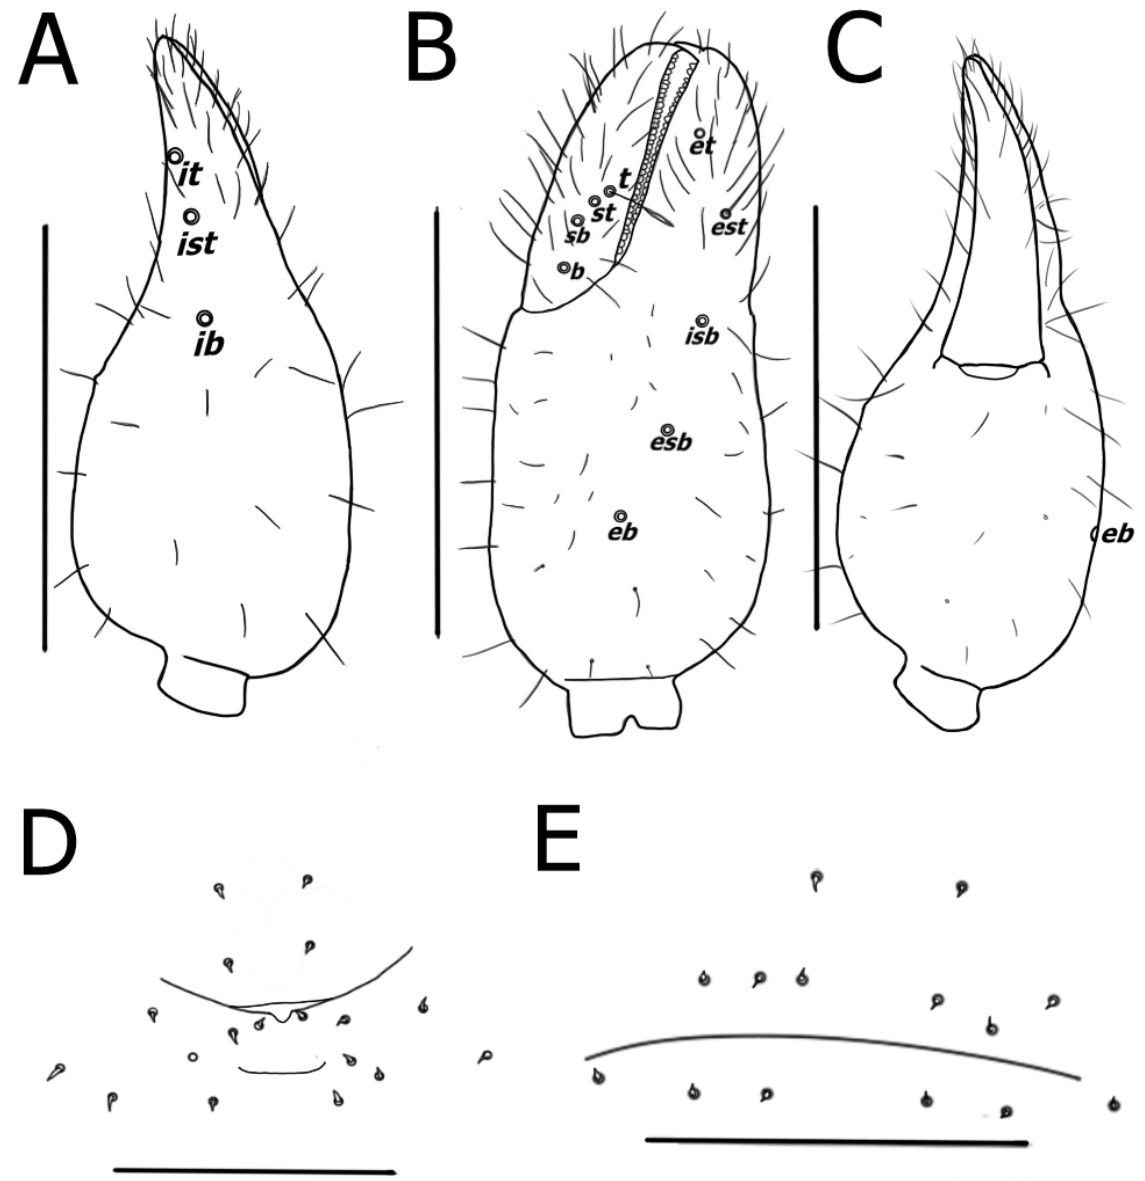
Fig. 18. Ideobisium susanae sp. nov. A . Chela in dorsal view, showing trichobothria. B . Chela in retrolateral view. C . Chela in ventral view. D . Outer genital area. E . Genital area. A–C, E: holotype, ♀ (QCAZ); D: allotype, ♂ (QCAZ). Scale bars: A–C = 0.50 mm; D = 0.20 mm; E = 0.10